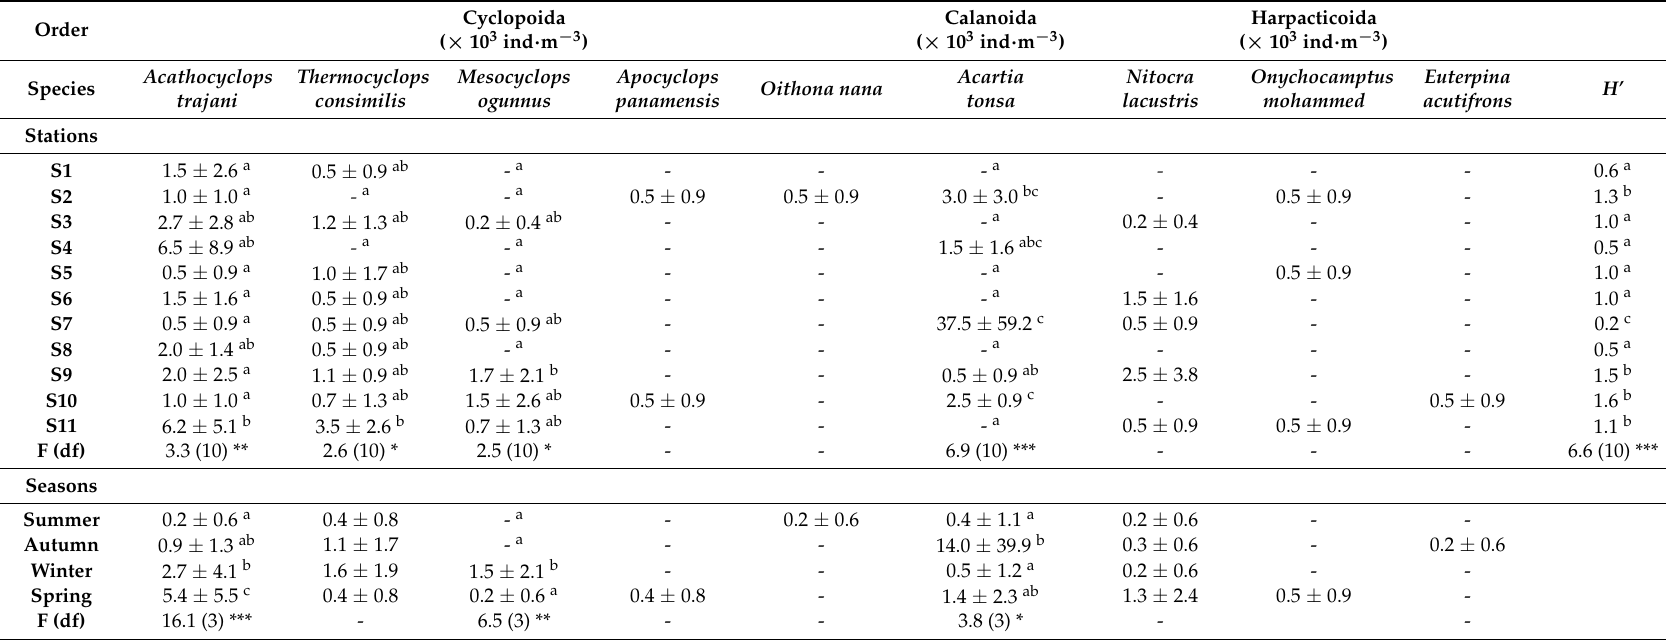
Table 3. Density of adult copepods observed in Lake Manzalah. Annual mean ± SD at each station and seasonal mean ± SD in the whole lake are shown. F -values (with indication of degrees of freedom, DFs) were determined by two-way ANOVA test, p -values for differences among stations and seasons within each species. Values in each line that share the same letter (a, b, c, d) are not significantly different ( p > 0.05). * p < 0.05, ** p < 0.01, *** p <